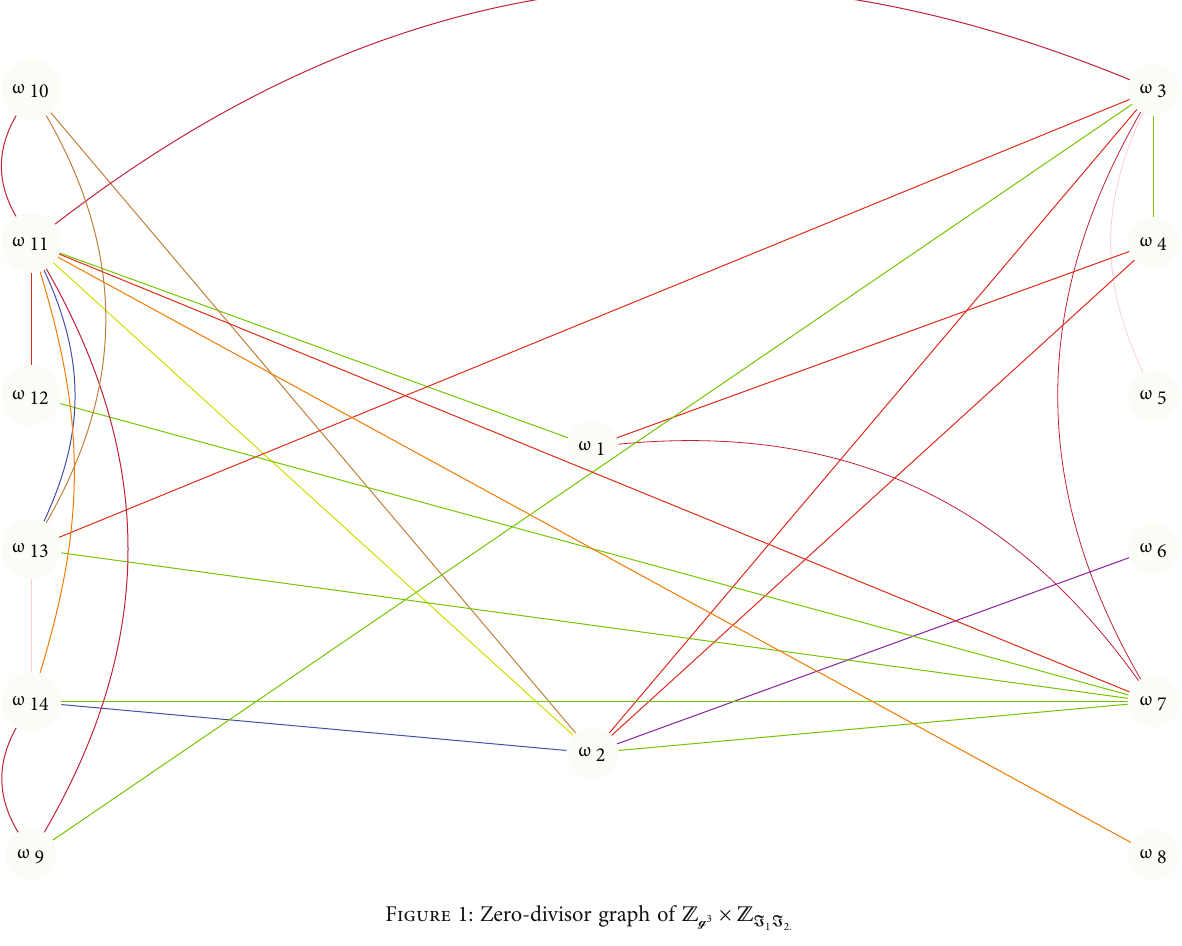
Figure 1: Zero-divisor graph of ℤ